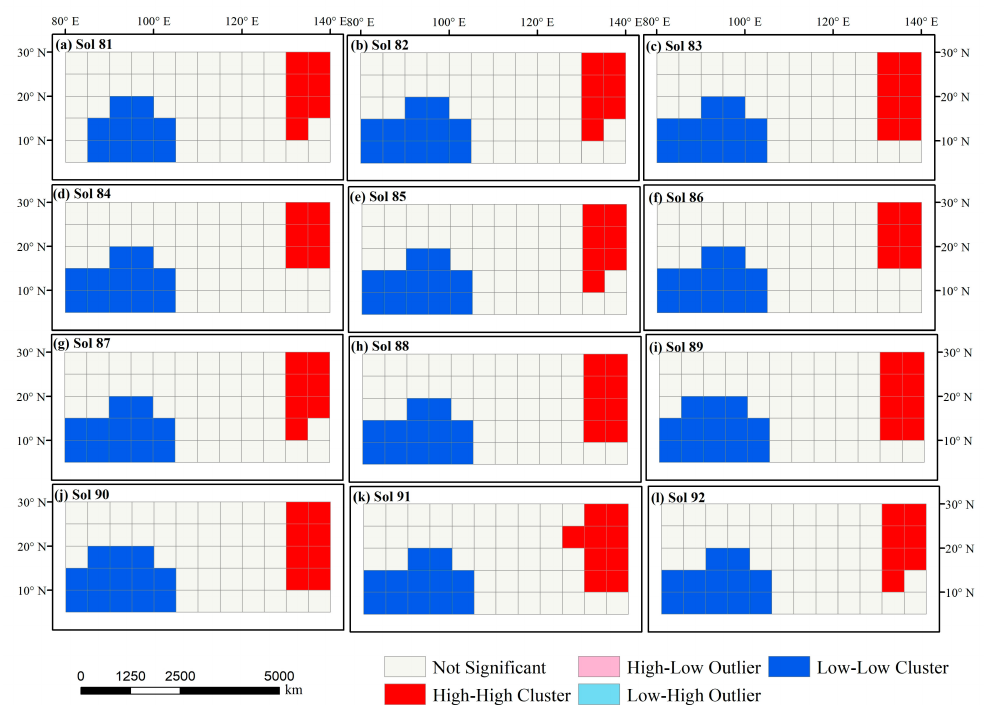
Figure 7. LISA for sol temperature range (STR) during sol 81–92 in Martian year 29. The LISA maps for STR during sol 81–111 from Martian years 29 to 32 are in the Supplementary Materials (Figures